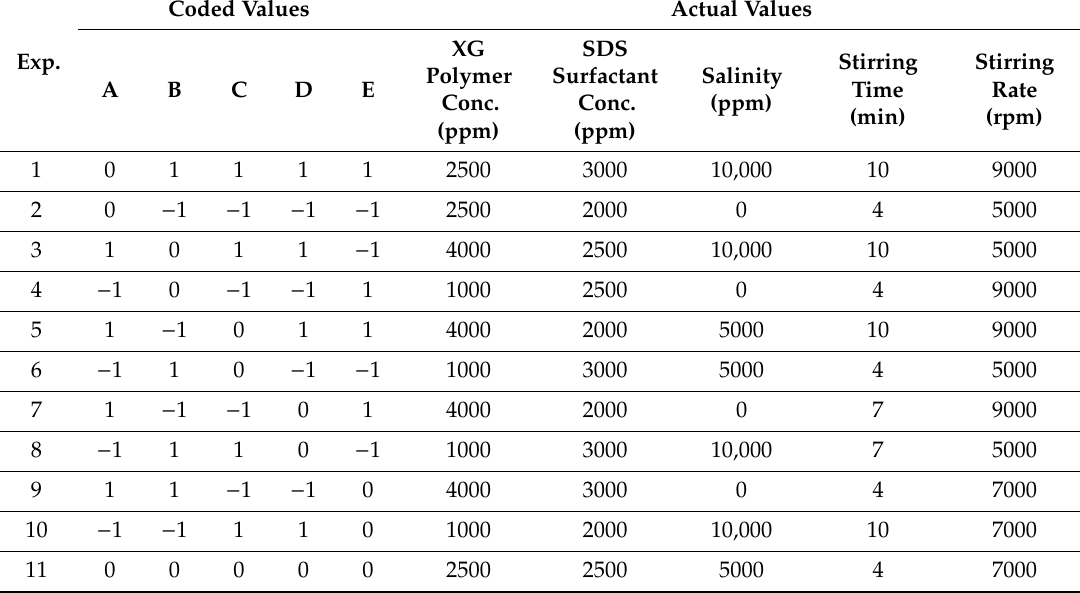
Table 2. DSD array